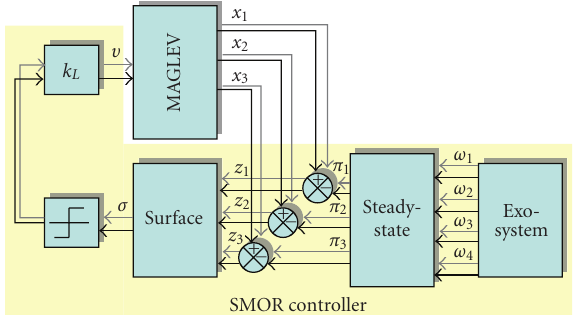
Figure 3: Schematic block diagram of SMOR.